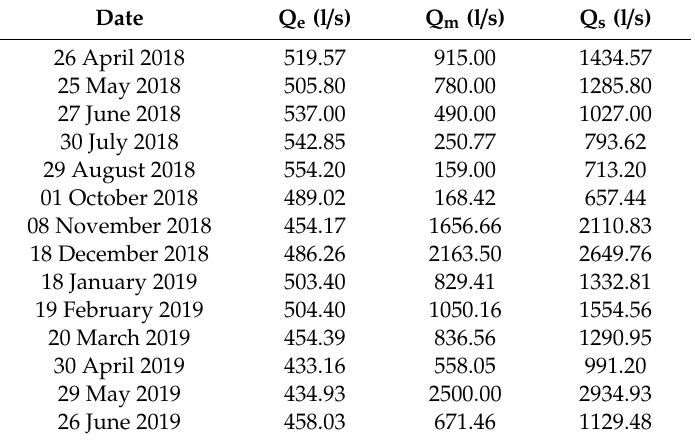
Table 2. Flow rates exploited for the local water supply (Qe), flow rate in excess measured in the river (Qm) and reconstruction of the discharges supplied by Capodacqua di Spigno Spring